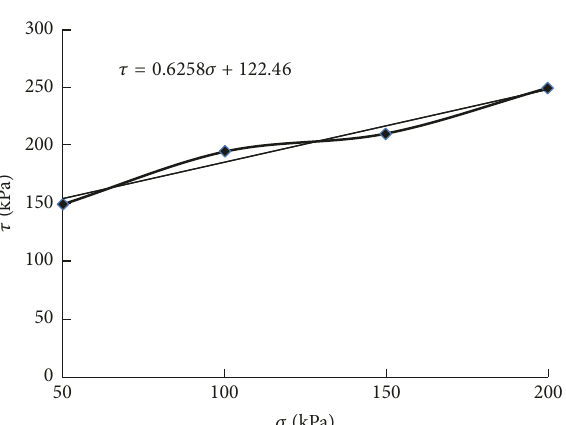
and 𝑏 = 0.095Δ𝑇 + 52.77 ; 𝑚 𝑐 is moisture content; Δ𝑇 is the temperature